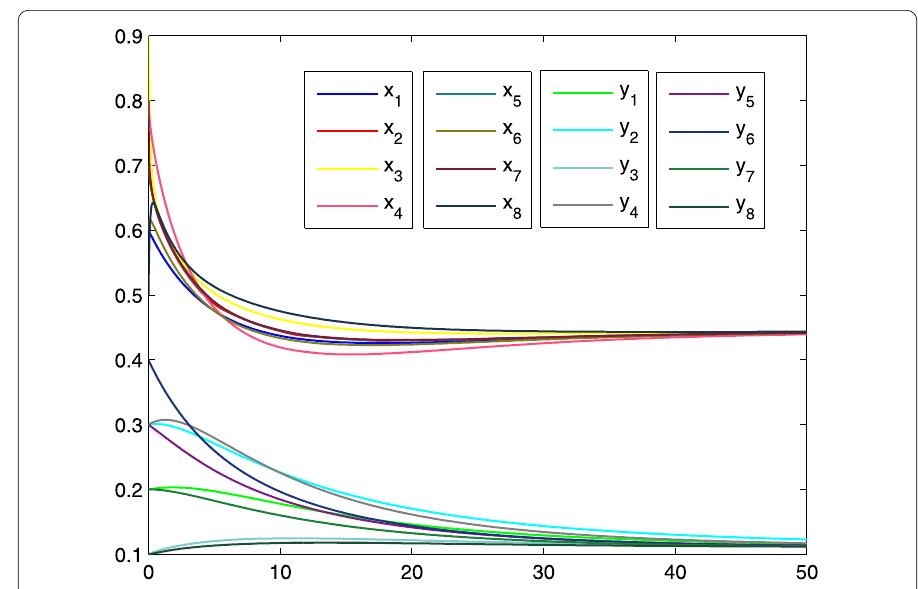
Figure 2 The solution of coupled predator-prey model with time-varying dispersal coefficient-matrix D 2 ( t ) when l =